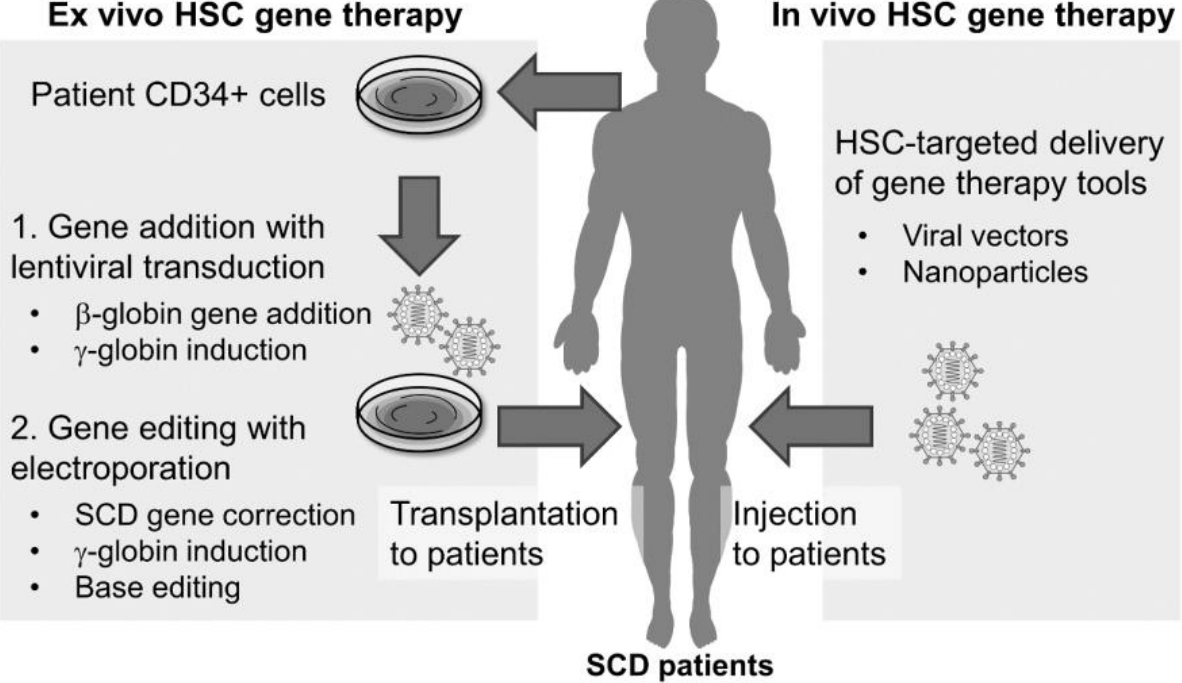
Figure 2. Comparison between ex vivo and in vivo HSC-targeted gene therapies in SCD.